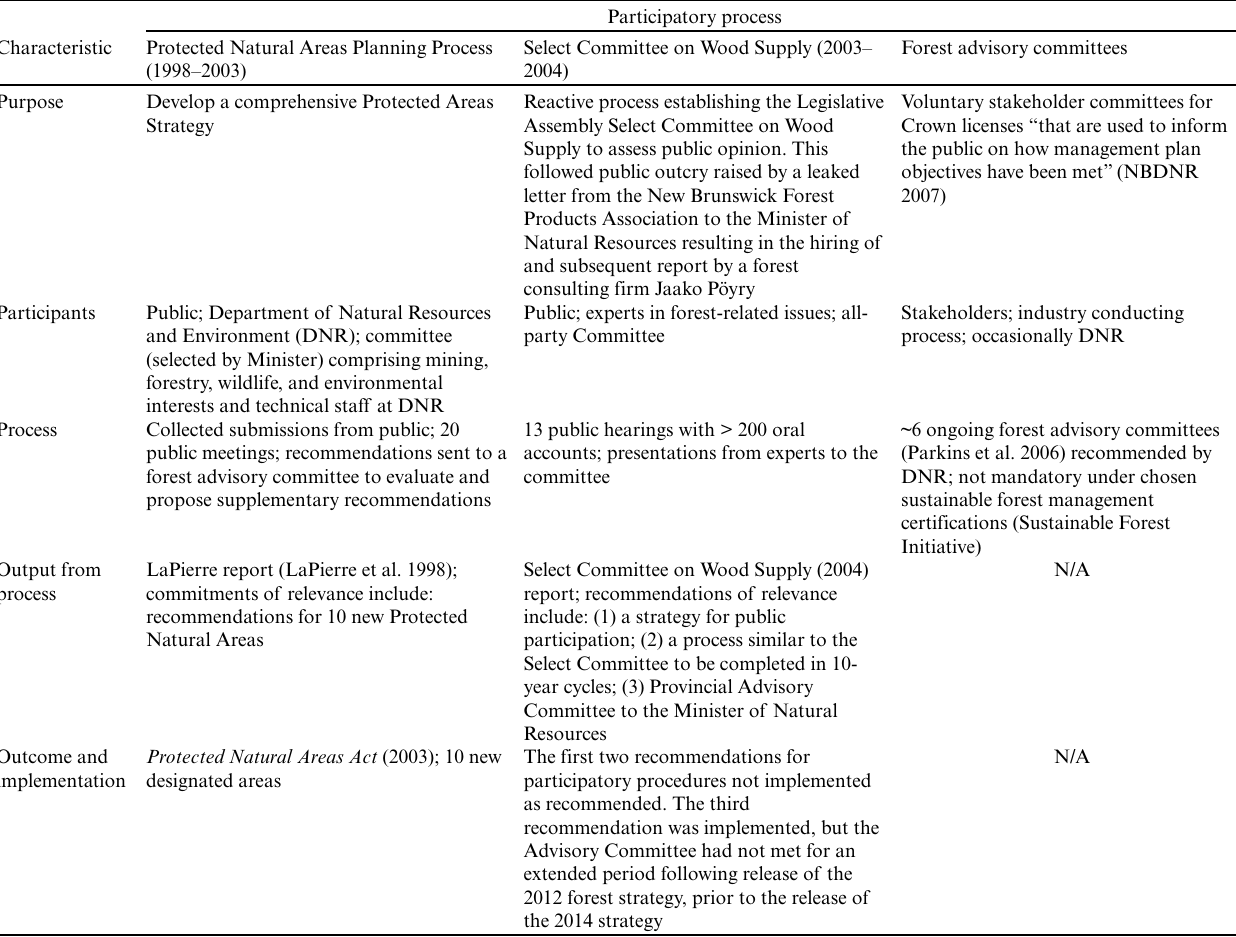
Table 2. Characteristics of the most-discussed participatory processes in New